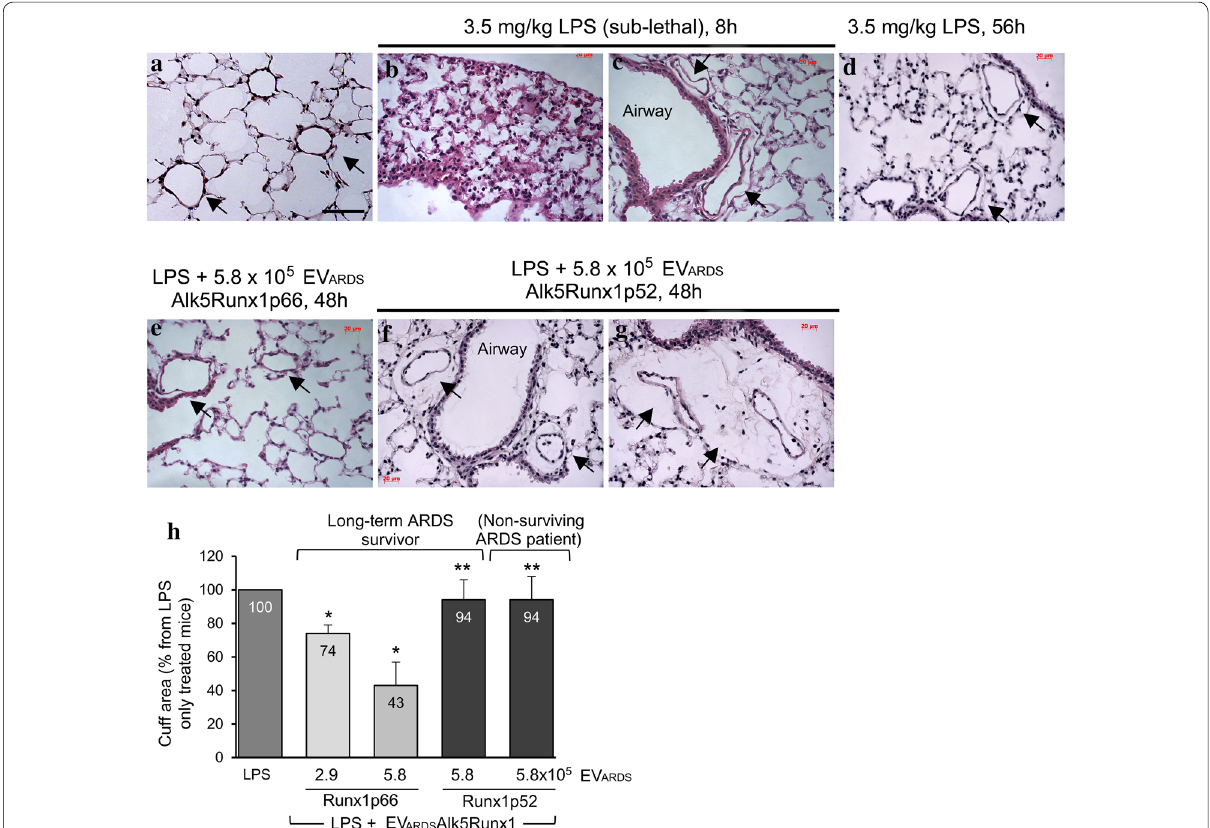
Fig. 7 EV ARDS Alk5Runx1p66 decrease lung histological severity and restore lung endothelial permeability in LPS-treated mice. Representative H&E of lung sections illustrates the extent of perivascular cuffs (arrows) and thickening of the interstitium in mice treated with LPS only ( b , c , d ), EV ARDS Alk5Runx1p66 ( e ), EV ARDS Alk5Runx1p52 isolated from the blood of a long-term ARDS survivor, week 1 in ICU, when the EV ARDS do not show Runx1p66 immunoreactivity ( f ) and EV ARDS Alk5Runx1p52 of a non-surviving ARDS ( g ). a Comparison the H&E staining of a control, untreated mouse lung section. h Morphometric analyses of perivascular cuff area using the NIH ImageJ software; only small and medium-sized (20